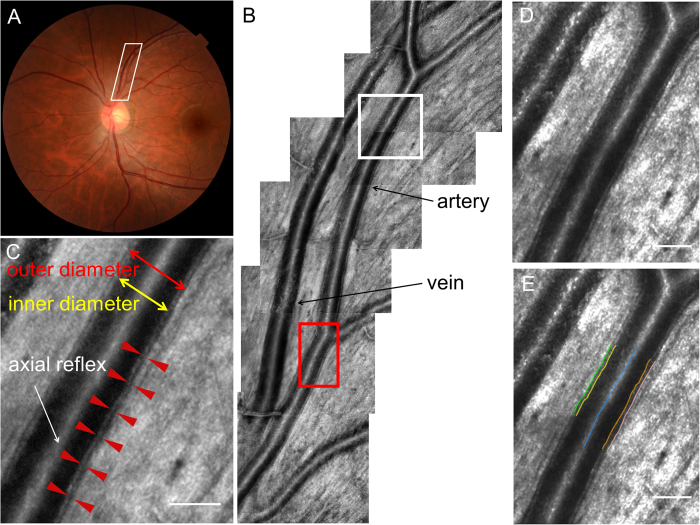
The visualization of the vascular wall using adaptive optics scanning laser ophthalmoscopy.(a) The fundus photograph of normal left eye. (b) The adaptive optics images in the area outlined in white on panel (a). The arterial wall was successfully visualized along the artery. However, the venous wall could not be visualized. (c) Magnified images outlined in white on panel (b). The interval between the tips of the 2 red arrowheads represents the arterial wall. Scale bar, 100 μm. (d) Magnified images outlined in red on panel (b). Scale bar, 100 μm. (e) The same magnified image as in panel (d) with the result from semi-automatic segmentation of vessel border lines. Retinal arterial wall borders were detected along the vessel’s running direction. After control points for the retinal arterial axes were set manually (blue line), vascular wall border detection was processed automatically Green and pink line represent outer wall borders. Yellow and orange line represent inner wall borders. Scale bar, 100 μm.